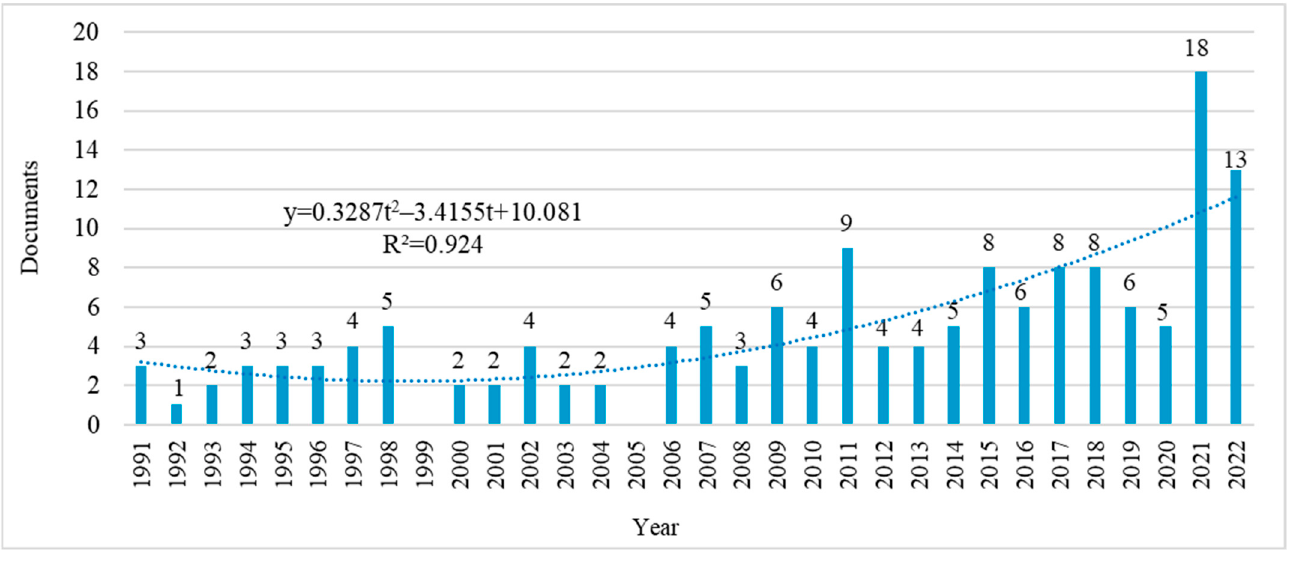
Figure 1. Global chronology of scientific publication activity on soil amelioration. Source: authors’ compilation based on the Scopus database.